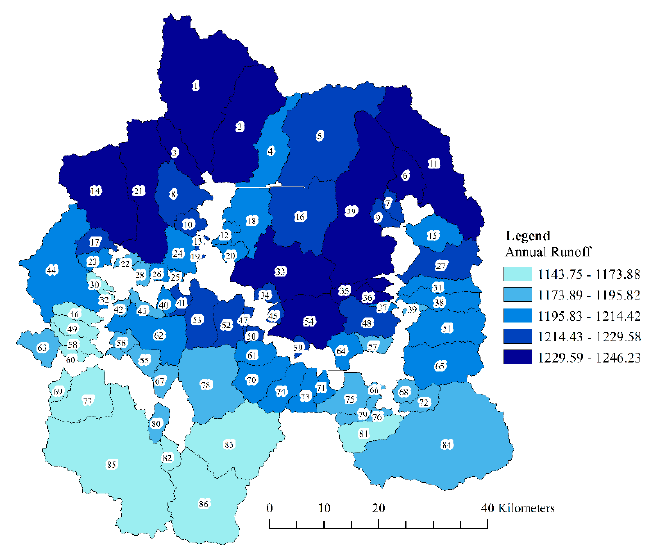
Figure 14. ( a ) Land use ( b ) Hydrologic soil group.